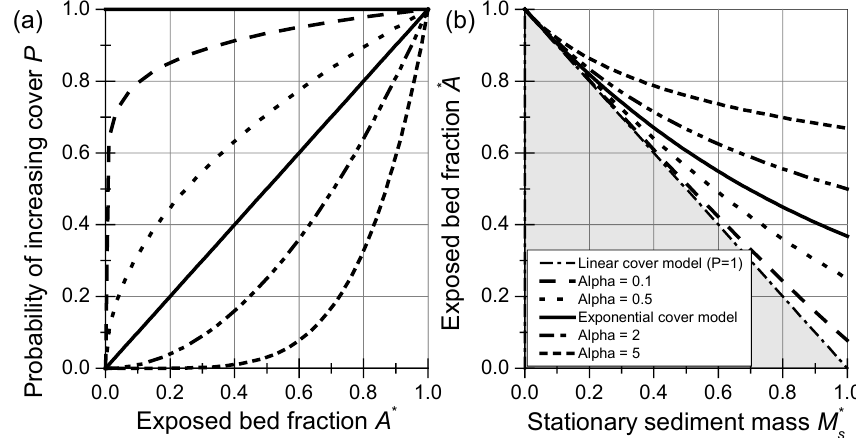
Figure 2. (a) Various examples for the probability function P as a function of bedrock exposure A ∗ . (b) Corresponding analytical solutions for the cover function between A ∗ and dimensionless sediment mass M ∗ s using Eqs. (6), (7), and (9). Grey shading depicts the area where the cover function cannot run due to conservation of mass.